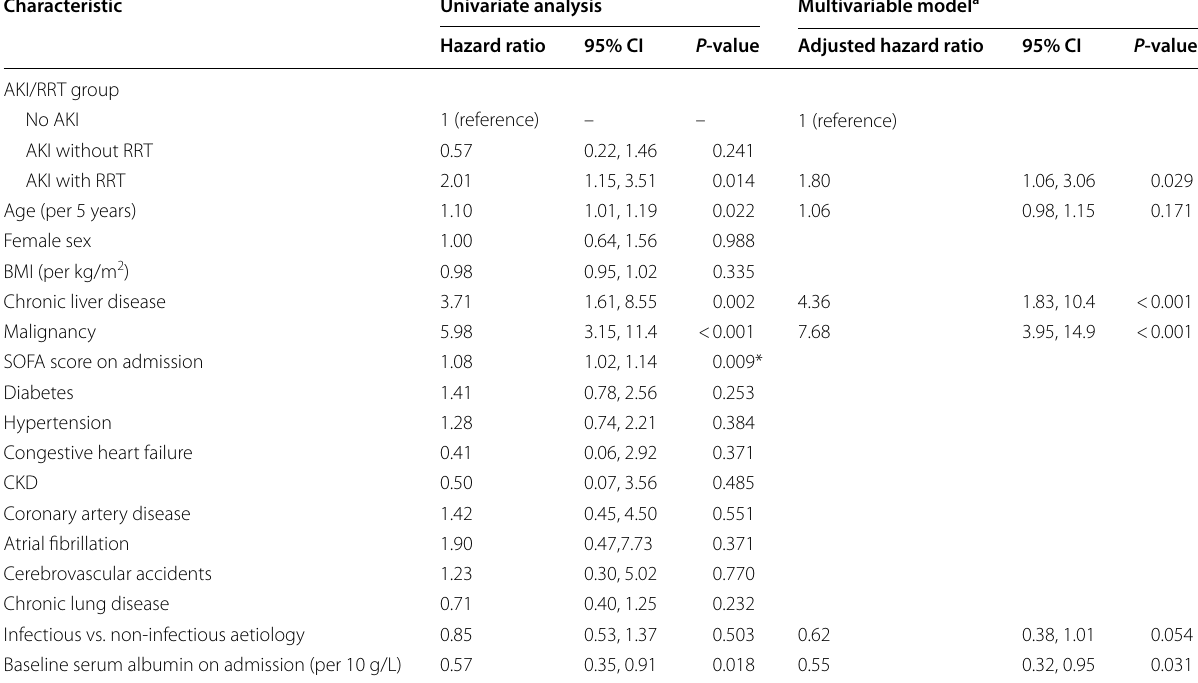
Table 4 Unadjusted and adjusted hazard ratios of the association between clinical characteristics and 1-year